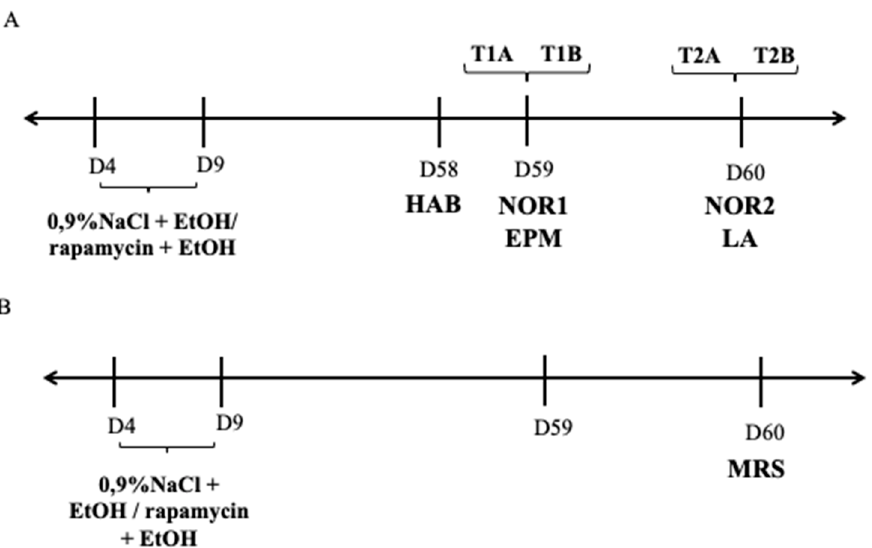
Figure 1. Diagram of experimental design. ( A ) 0.9%NaCl (i.p.); EtOH—ethanol (i.g.); rapamycin